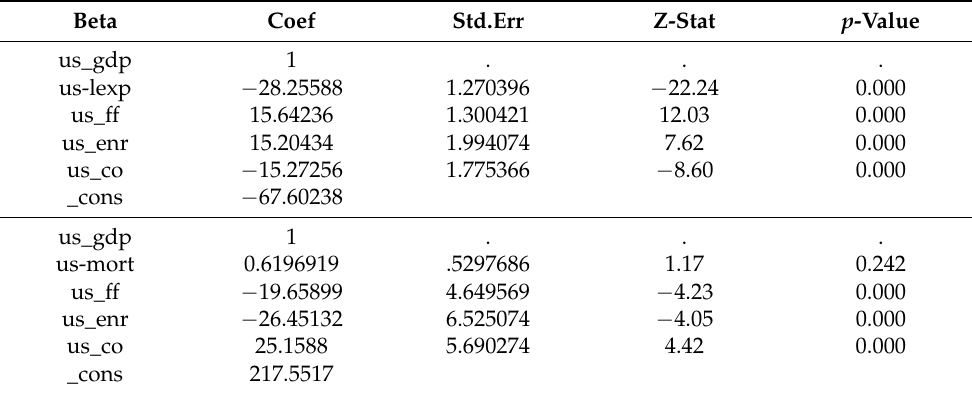
Table 12. Johansen normalization restriction imposed for